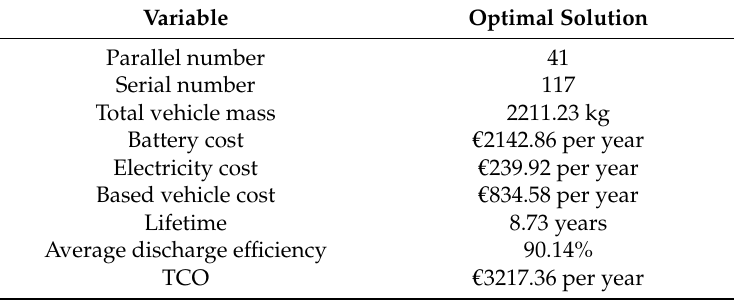
Table 6. The results under a mixed cycle combined with UDDS and HWFET